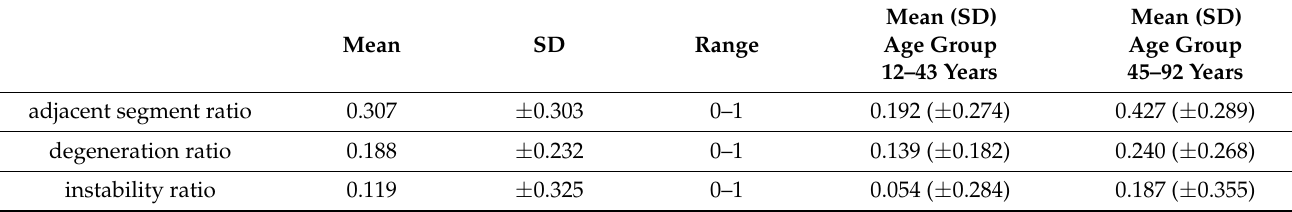
Table 3. Quantification of adjacent segment disease in all patients (n = 51) and in the two age groups. Ratios for adjacent segment disease (degeneration in the two segments next to the block vertebra) and ratio for degeneration (degeneration in the remaining cervical segments); the difference between these two ratios represents the instability ratio, quantifying whether the presence and degree of degeneration adjacent to the block vertebra exceeds the degeneration of the remaining spinal segments; SD: standard